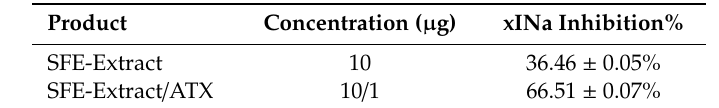
Table 2. Amiloride-sensitive sodium current amplitude variation as a function of SFE-Extract and / or ATX concentrations (4–6 experiments).